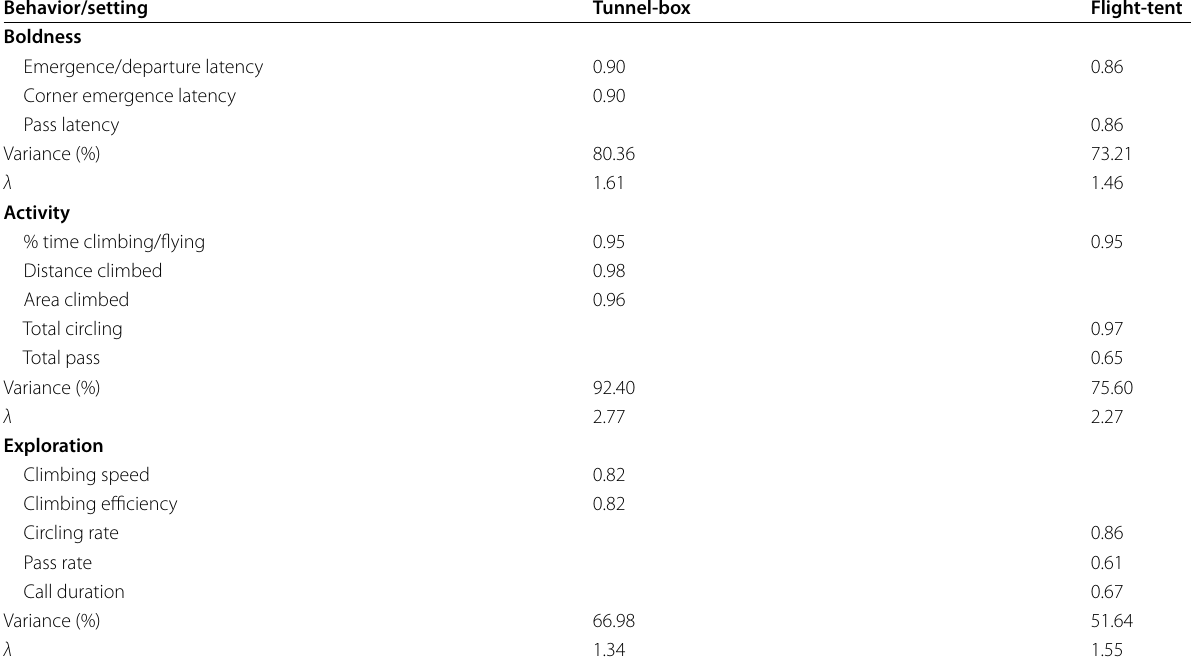
Table 4 Behaviors with medium or high repeatability ( R ≥ 2 ) displayed by eastern bent-wing bats in tunnel-box and flight-tent tests, and the respective PC loadings, cumulative variance explained, and eigenvalues ( λ ) shown under each behavioral category. Behavior/setting